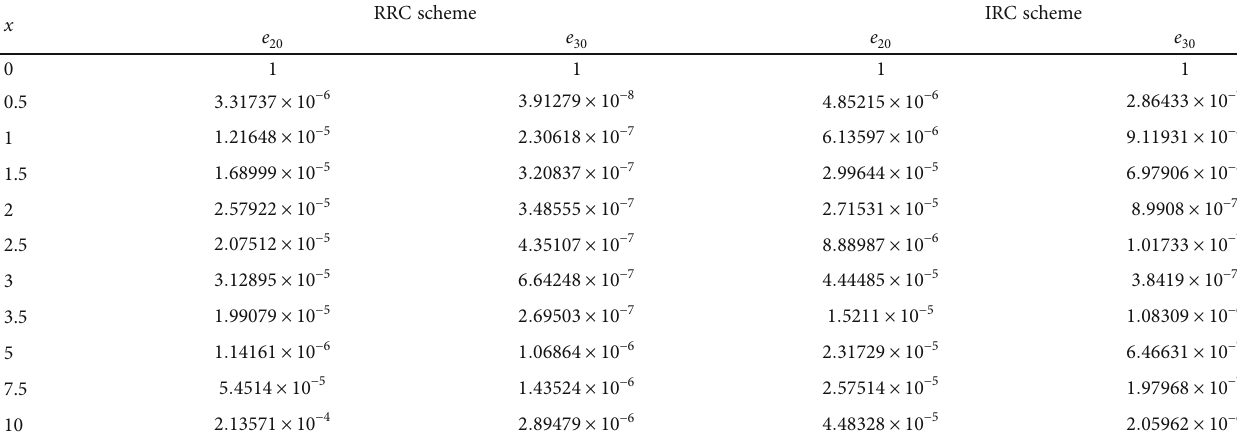
Table 3: Comparison between absolute errors with λ = 2 given by two proposed